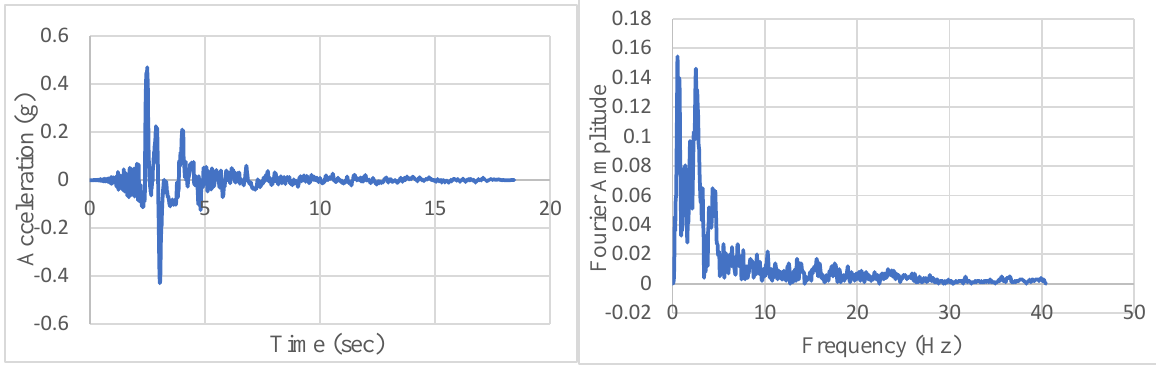
Figure 17. Selected ground motion record and Fourier spectra: Imperial Valley (El Centro) earthquake. Table 6. Selected ground motions.